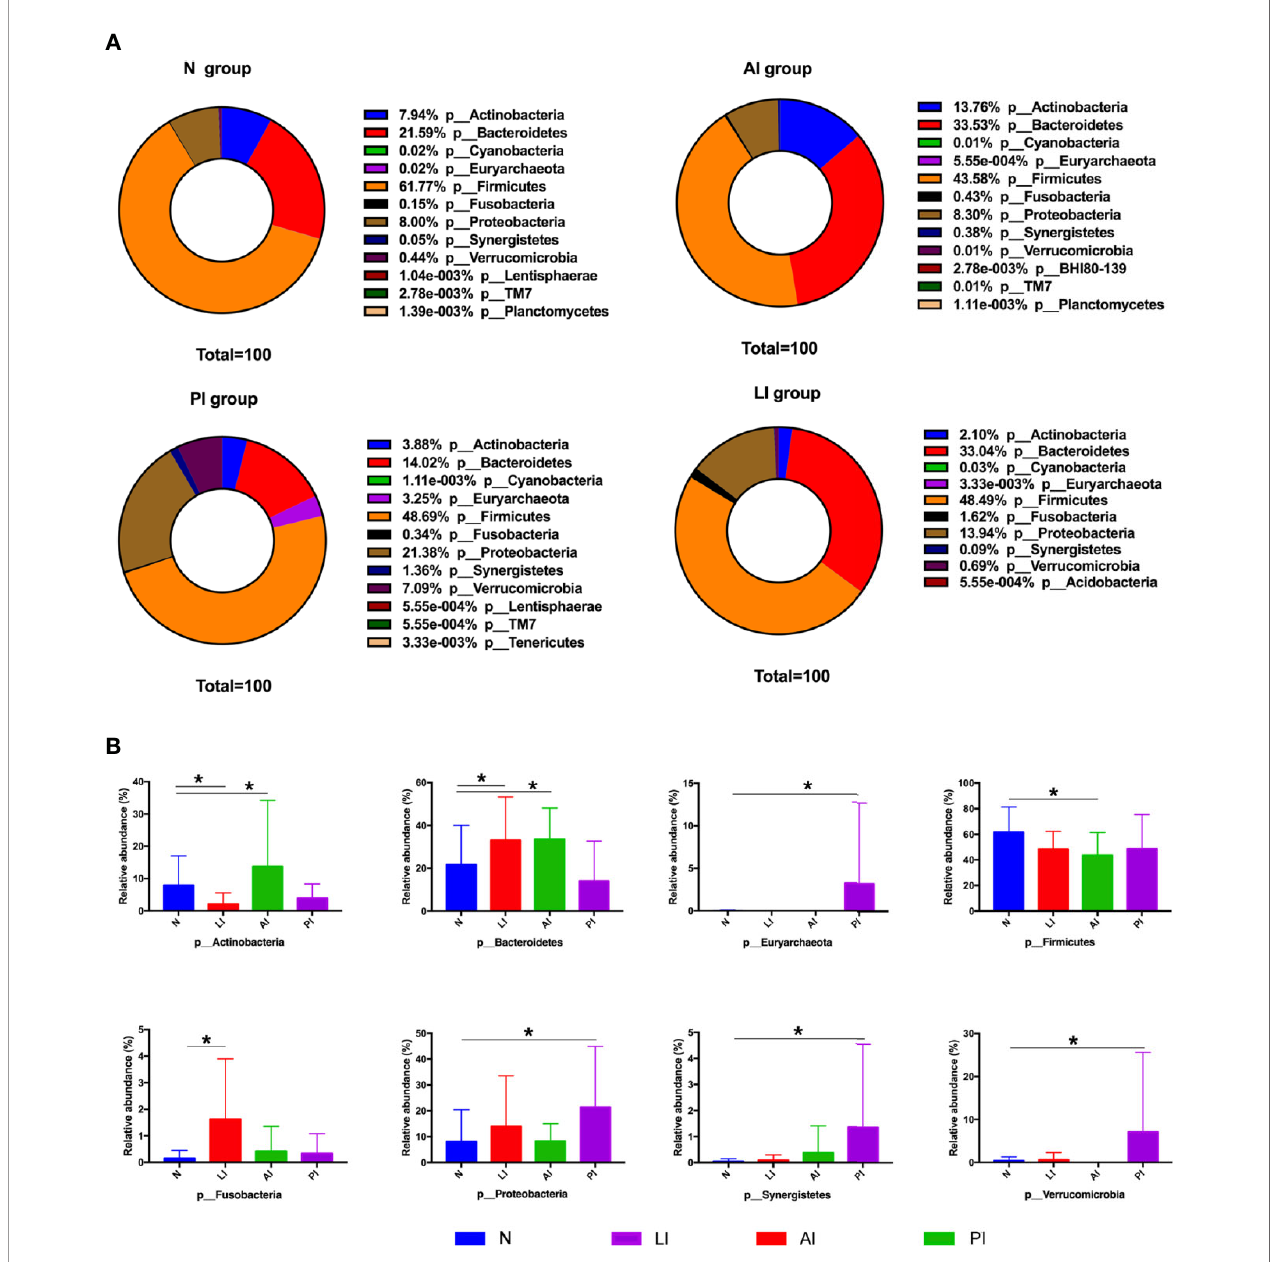
FIGURE 3 | (A) Taxonomic pro fi ling assigned most OTUs to Firmicutes , Bacteroidetes , Actinobacteria , Proteobacteria , Verrucomicrobia , and Fusobacteria at the phylum level. (B) Among-group differences at the phylum level. *P <